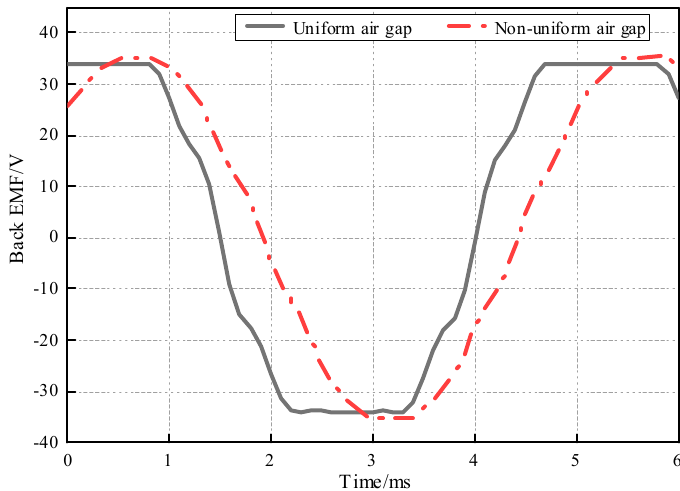
Figure 10. Comparison diagram of back EMF with different air gaps.